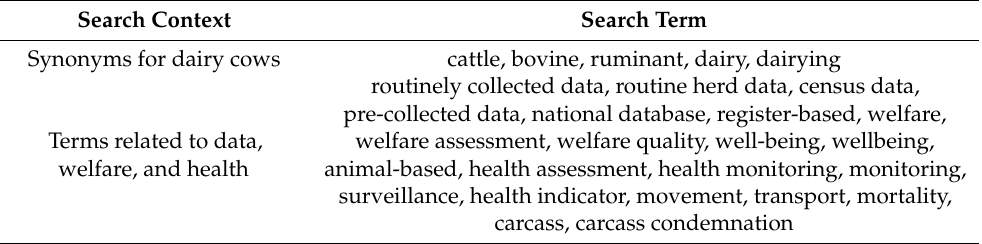
Table 1. Search terms used in the initial literature identification.